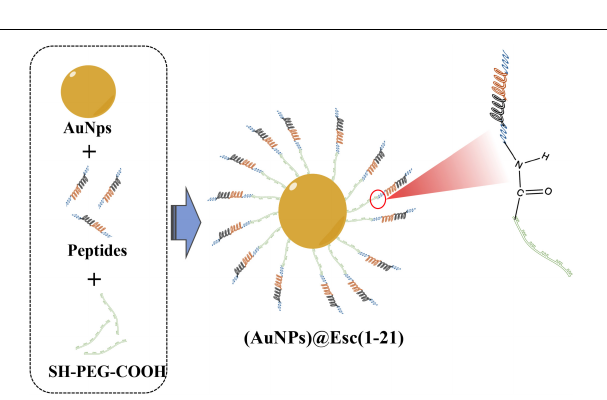
FIGURE 4 | The composition of gold nanoparticles